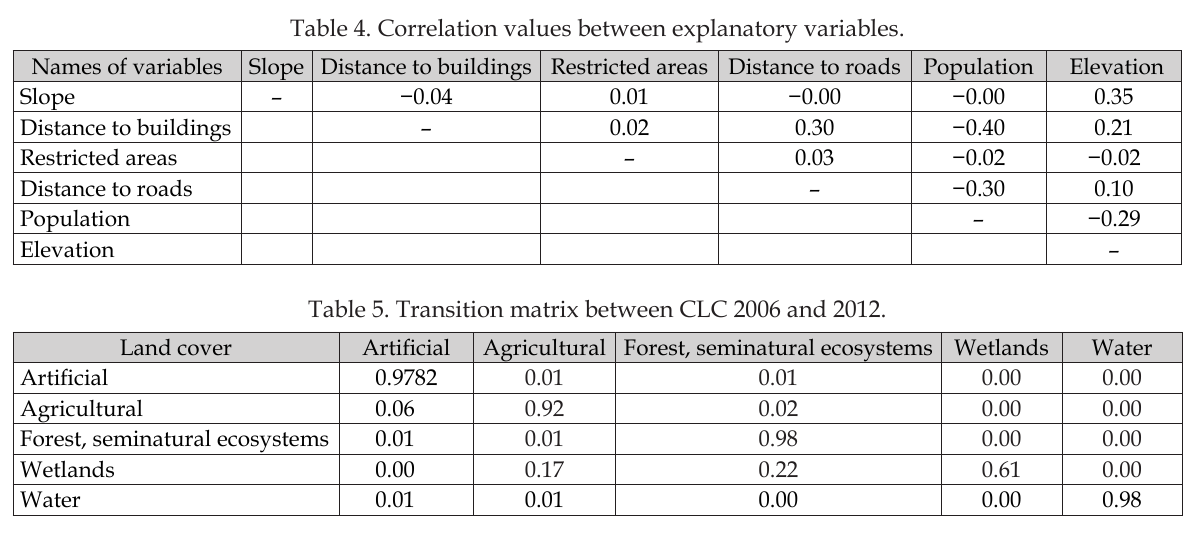
Table 6. Land cover and land cover change statistics [in km 2 ]